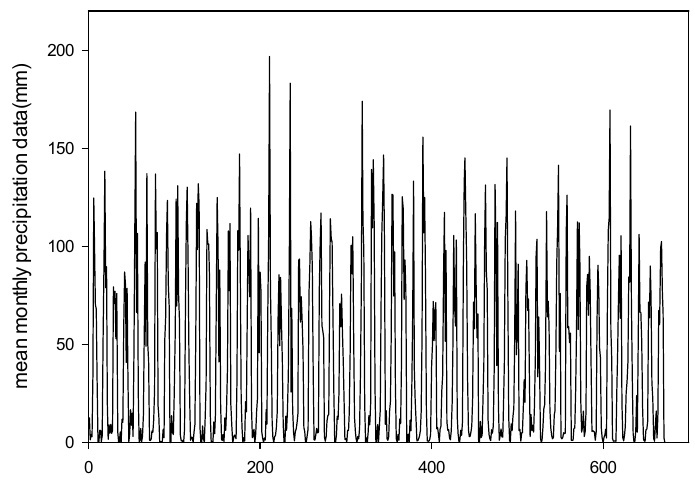
Figure 5. Original data sequence diagram.